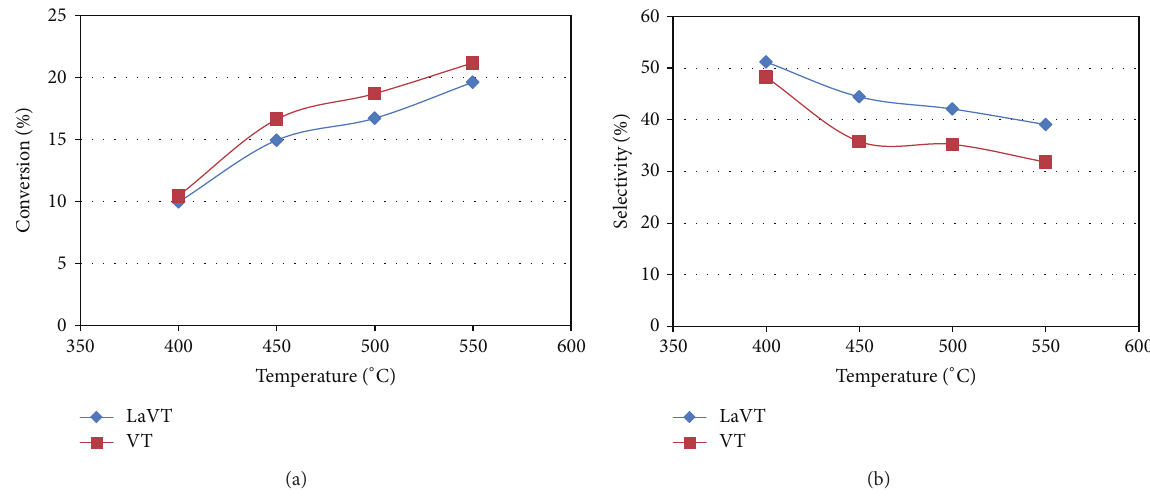
Figure 6: Conversion (a) and total alkene’s selectivity (b) as functions of reaction temperature for VT and